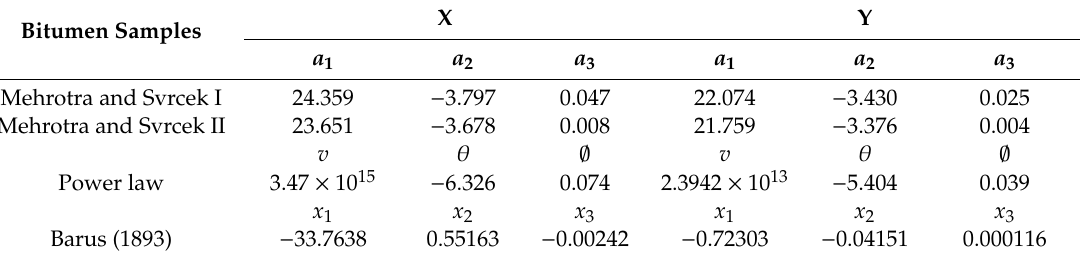
Table 2. Correlation constants for the calculated viscosities of the oil